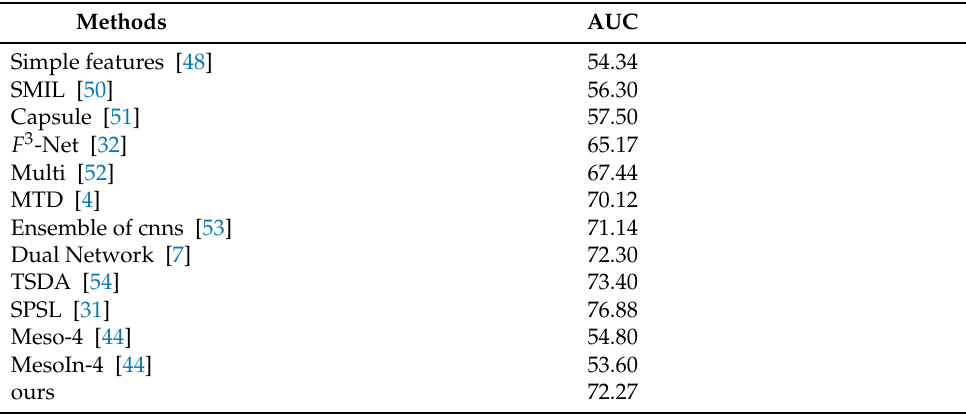
Table 4. The AUC results of cross-database testing